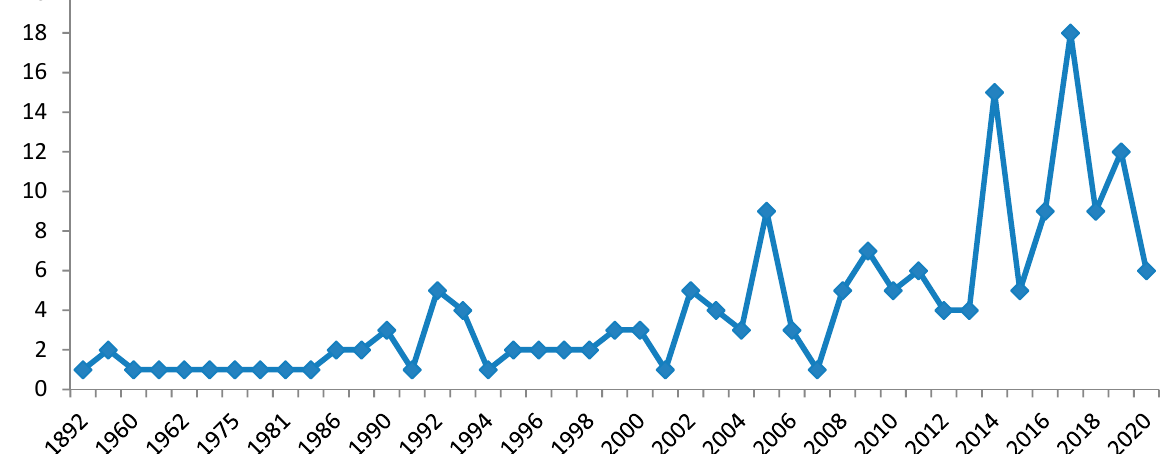
Figure 1. Distribution of Articles over Time. Note: made by the authors.